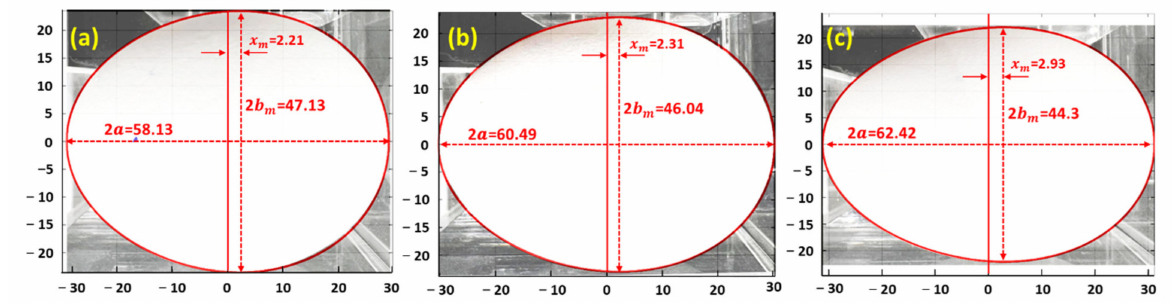
Figure 3. The actual egg shape and egg-shaped curve drawn by Equations (3) and (15)–(17). The SI ( a ) is 81.08; ( b ) 76.11; ( c )